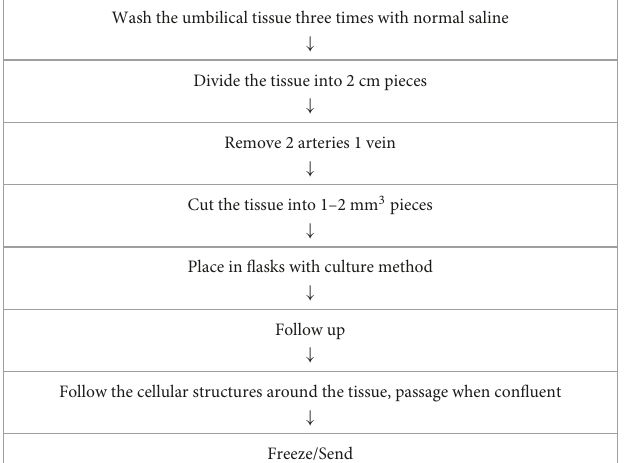
TABLE 2 Production of the clinical grade mesenchymal stem cells from umbilical cord tissue in good manufacturing practice (GMP) laboratory. Wash the umbilical tissue three times with normal saline